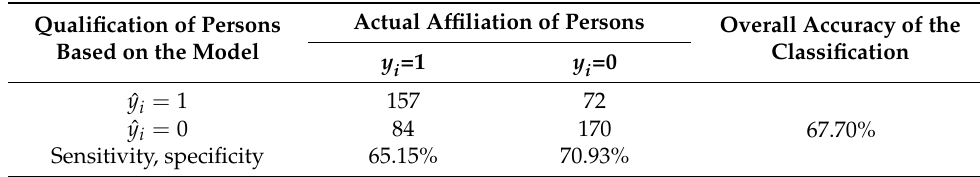
Table 7. Classification accuracy of the logit model.